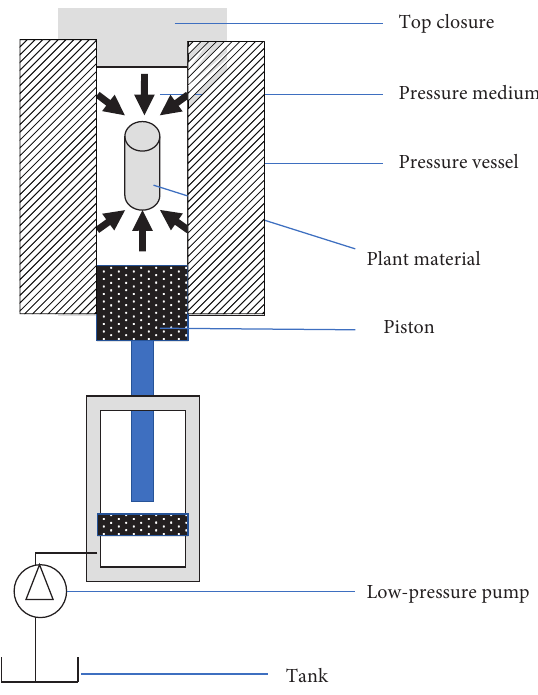
Figure 6: Scheme of high hydrostatic pressure